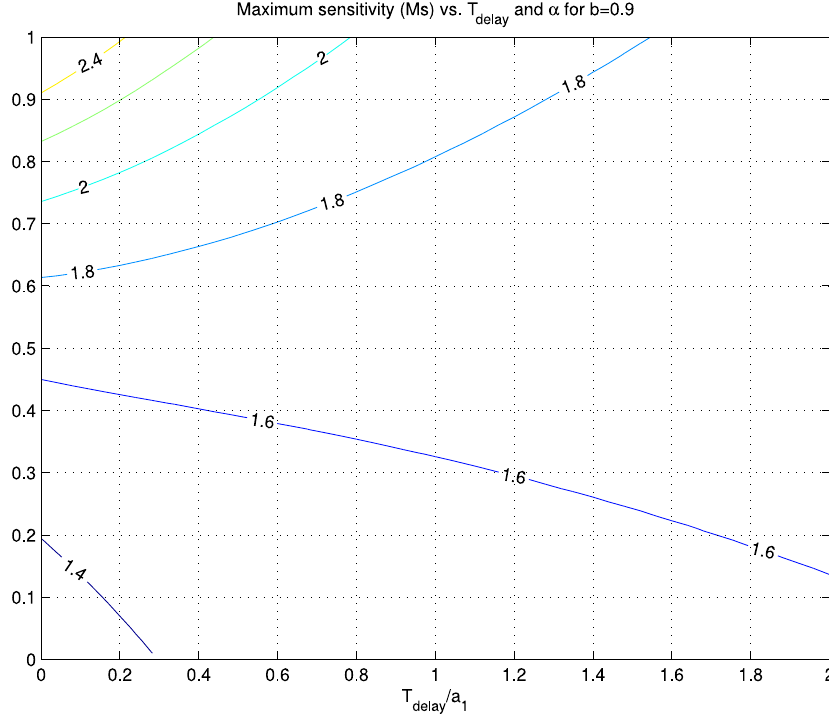
Figure 7. Closed-loop maximum sensitivity (M S ) for G ( s ) and controller parameter b = 0.9 at different values of process parameters T delay and α.